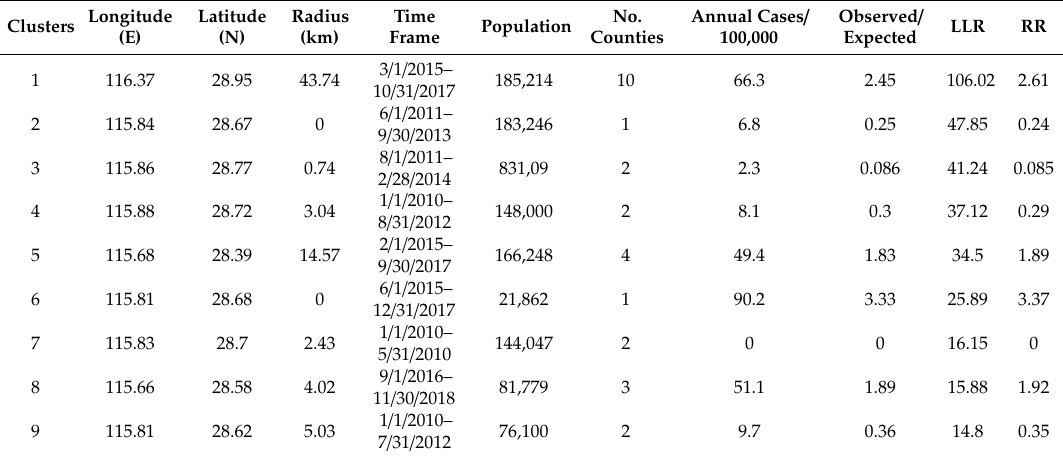
Table 2. Spatiotemporal clusters of tuberculosis cases in the study areas, 2010–2018.